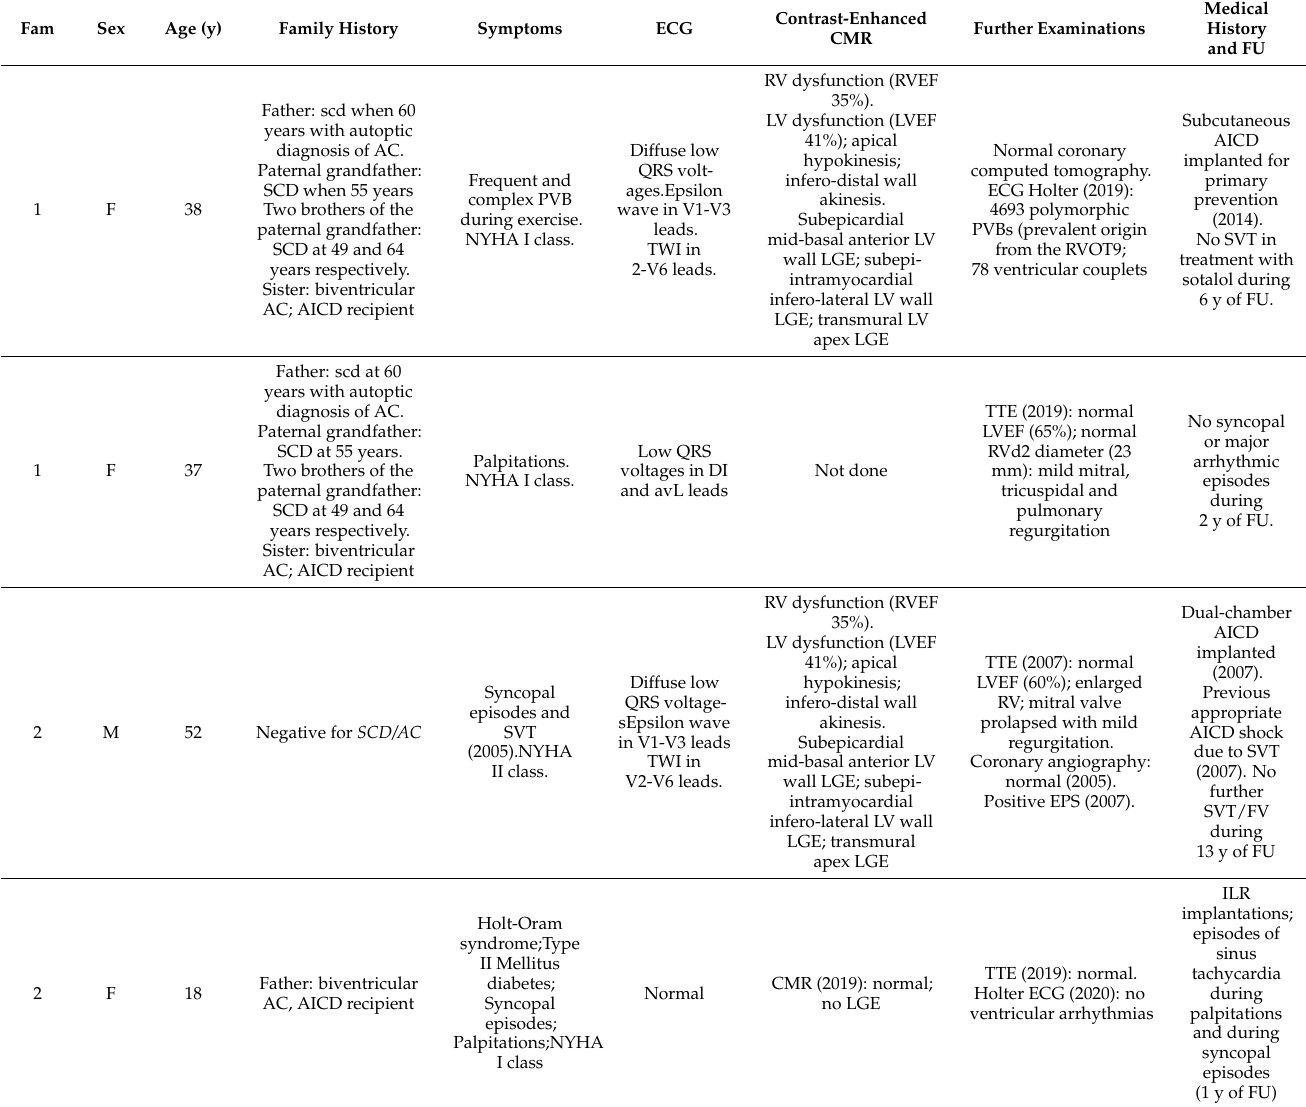
Table 1. Clinical